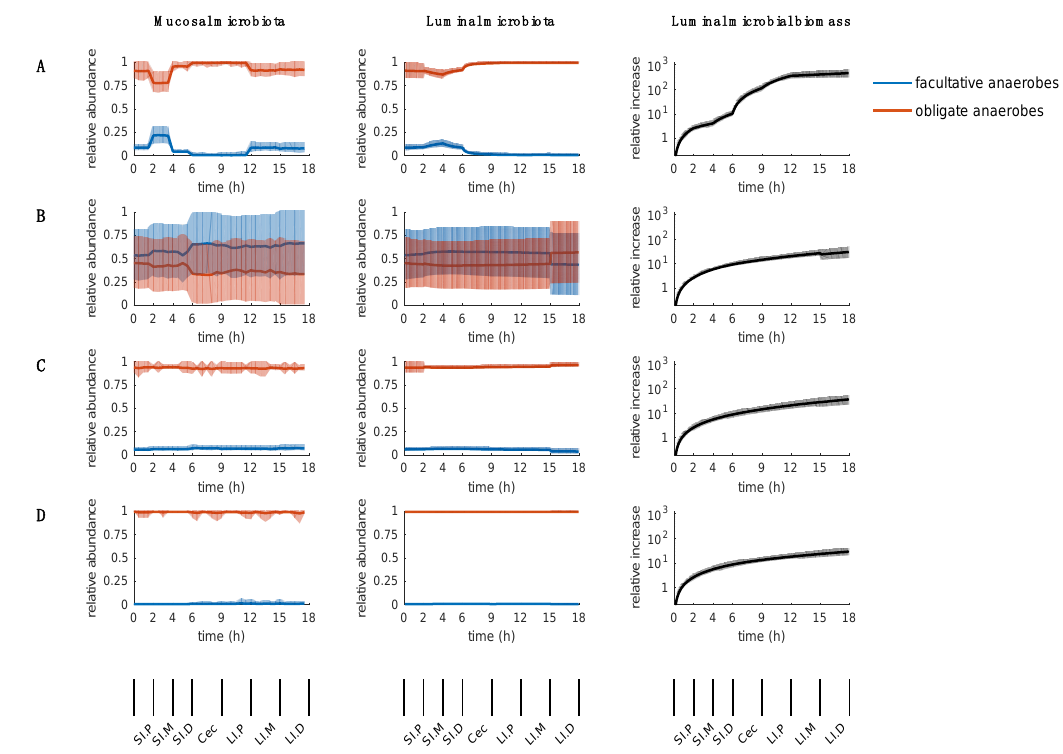
Figure 4. Varying the biomass density of the mucosal microbiota X total muc as detailed in Table 2. ( A ) Default, experimental values, ranging from ~10 − 6 to ~10 − 4 . ( B ) Test 1, constantly 10 − 6 gdw g − 1 . ( C ) Test 2, constantly 10 − 5 gdw g − 1 . ( D ) Test3, constantly 10 − 4 gdw g − 1 .